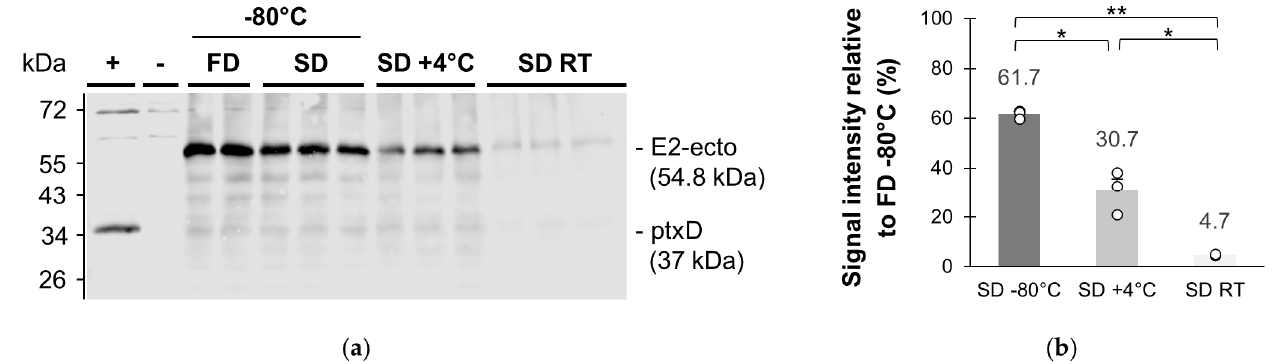
Figure 4. Evaluation of E2-ecto vaccine stability in spray-dried microalgal powder after long-term storage at different temperatures. ( a ) Immunoblot analysis of E2-ecto vaccine in spray-dried (SD) microalgal powder stored at –80 ◦ C, +4 ◦ C and ambient temperature (RT) for 27 months. The freeze- dried (FD) microalgal powder stored at –80 ◦ C in similar conditions was used as reference. Each sample was analysed in technical triplicates, except for the FD powder, for which one of the replicates was lost during storage. Samples were normalized at 30 µ g of biomass loaded per well. Positive control (+): TN72:ptxD, negative control (–): TN72:pSRSapI. ( b ) Densitometry analysis in the 800 nm channel of the spray-dried (SD) samples stored at –80 ◦ C, +4 ◦ C and ambient temperature for 27 months. Data are expressed as the average signal intensity relative to the average signal intensity of the FD powder stored at –80 ◦ C ± one standard error. Individual data points are shown as white circles. Student’s t-tests were applied, with statistically significant and highly significant differences identified with * ( p -value < 0.05) and ** ( p -value < 0.01), respectively.